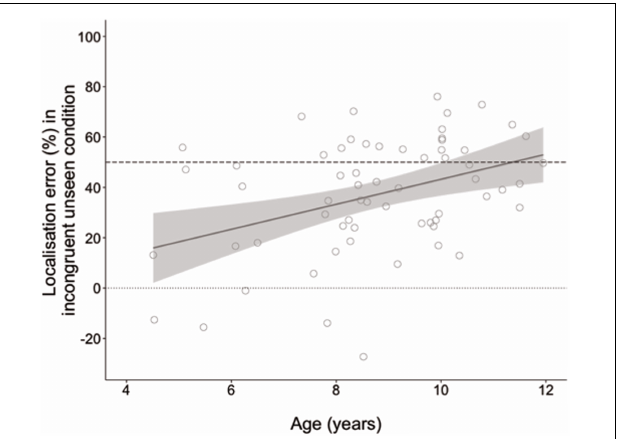
FIGURE 3 | Localization error as a percentage of distance between seen and actual hand locations in the incongruent unseen condition in which the seen and real hands were in different locations. The dashed line at 50% indicates equal weighting of vision and proprioception; the dotted line at zero indicates complete reliance on proprioception. Negative values indicate estimates beyond the real hand location. Shaded region shows 95% confidence